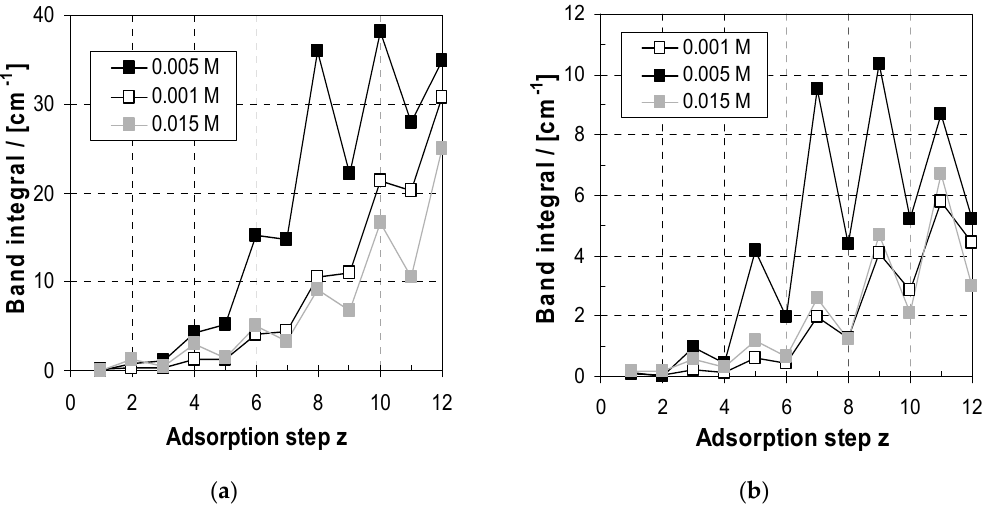
Figure 8. ( a ) A PEI of PEM-z plotted versus adsorption step z = 1 to 10 for c PEL = 0.001, 0.005, 0.015 M. ( b ) A PAA of PEM-z plotted versus adsorption step z = 1 to 10 for c PEL = 0.001, 0.005, 0.015 M.